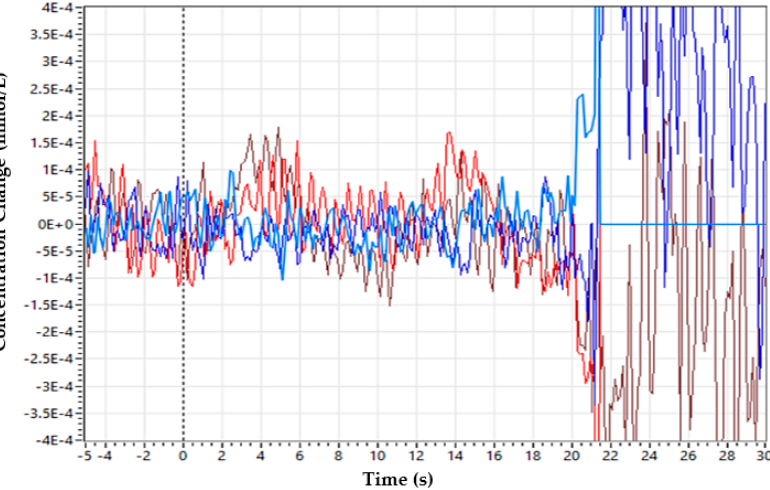
Figure 9. Disturbed/noisy signal before grommets and covering head cap is incorporated. Blue lines represent the data acquired from the detector while the red line represents the source signal.